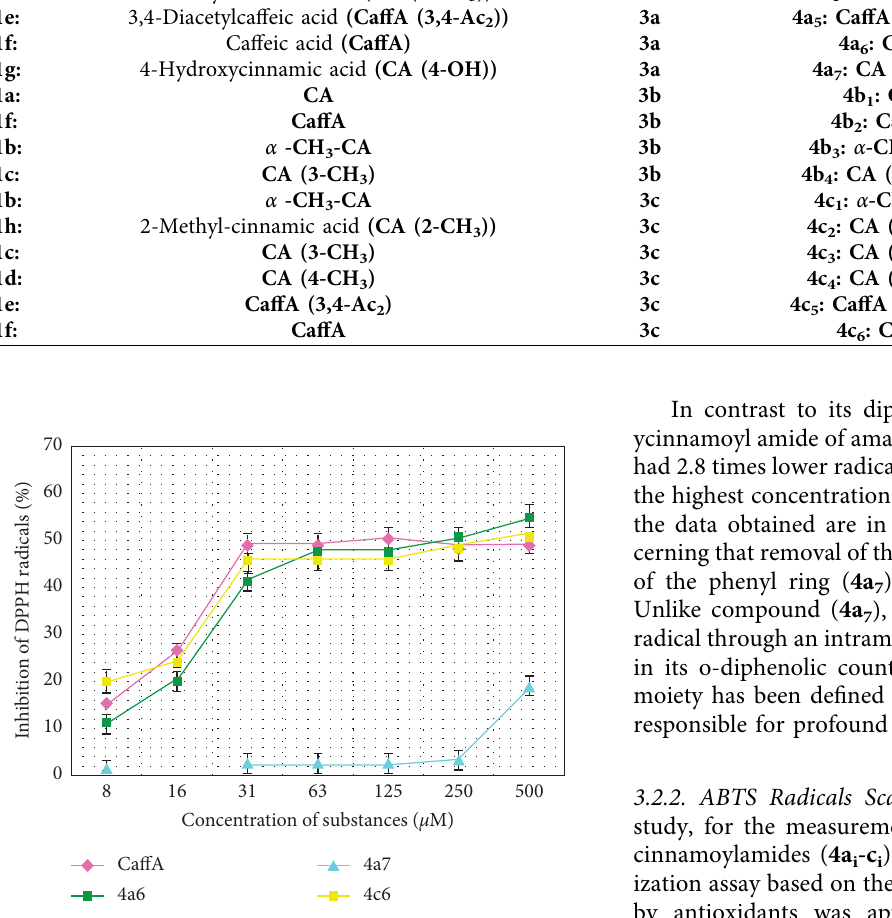
Figure 1: DPPH radicals inhibition (%) of the tested substances, applied in diferent concentrations (from 8 to 500 µ